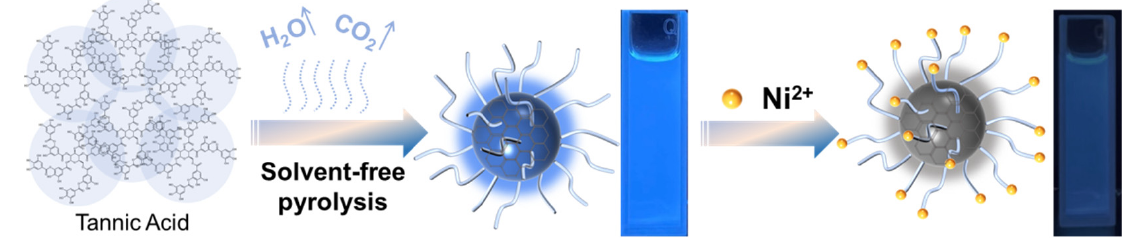
Figure 8. Decay curve of PL intensity of CDs-Hydro, CDs-250-400 with increasing ( a ) visible and ( b ) UV irradiation time. ( c ) Decay curve of PL intensity of CDs-Hydro, CDs-250-400 with increasing temperature.